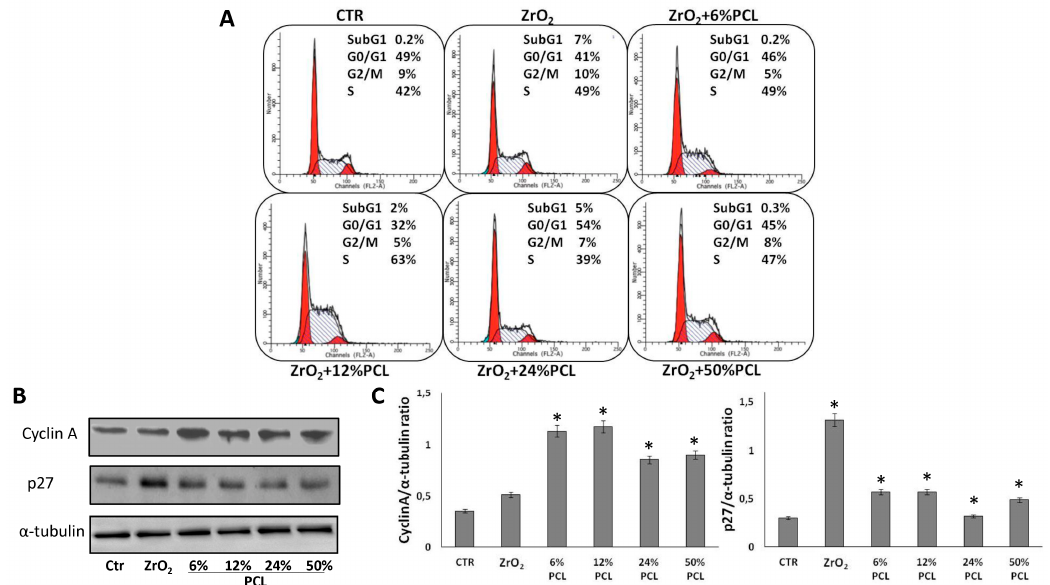
Figure 5. Effects of ZrO 2 material alone and PCL/ZrO 2 hybrid materials with different PCL percentages (6 wt %, 12 wt %, 24 wt %, 50 wt %) on the distribution of NIH-3T3 cells in cell cycle phases and on the levels of some relevant cell cycle regulating proteins. NIH-3T3 cells were cultured in the absence (control, CTR) or presence of the indicated substances for 48 h. ( A ) FACS analysis of propidium iodide stained cells. Profiles and quantitative data indicating the percentage of G0/G1, S, and G2/M cells from a typical representative experiment; ( B ) 30 µ g of cell extracts were subjected to SDS-PAGE and blotted with antibodies against the indicated proteins ( α -tubulin was used as a standard for the equal loading of protein in the lanes). The image is representative of two immunoblotting analyseis from two different cellular preparations with similar results; ( C ) Graphs showing the densitometric intensity of Cyc A and p27/tubulin bands ratio. The intensities of signals were expressed as arbitrary units. * p < 0.05 vs. control untreated cells.